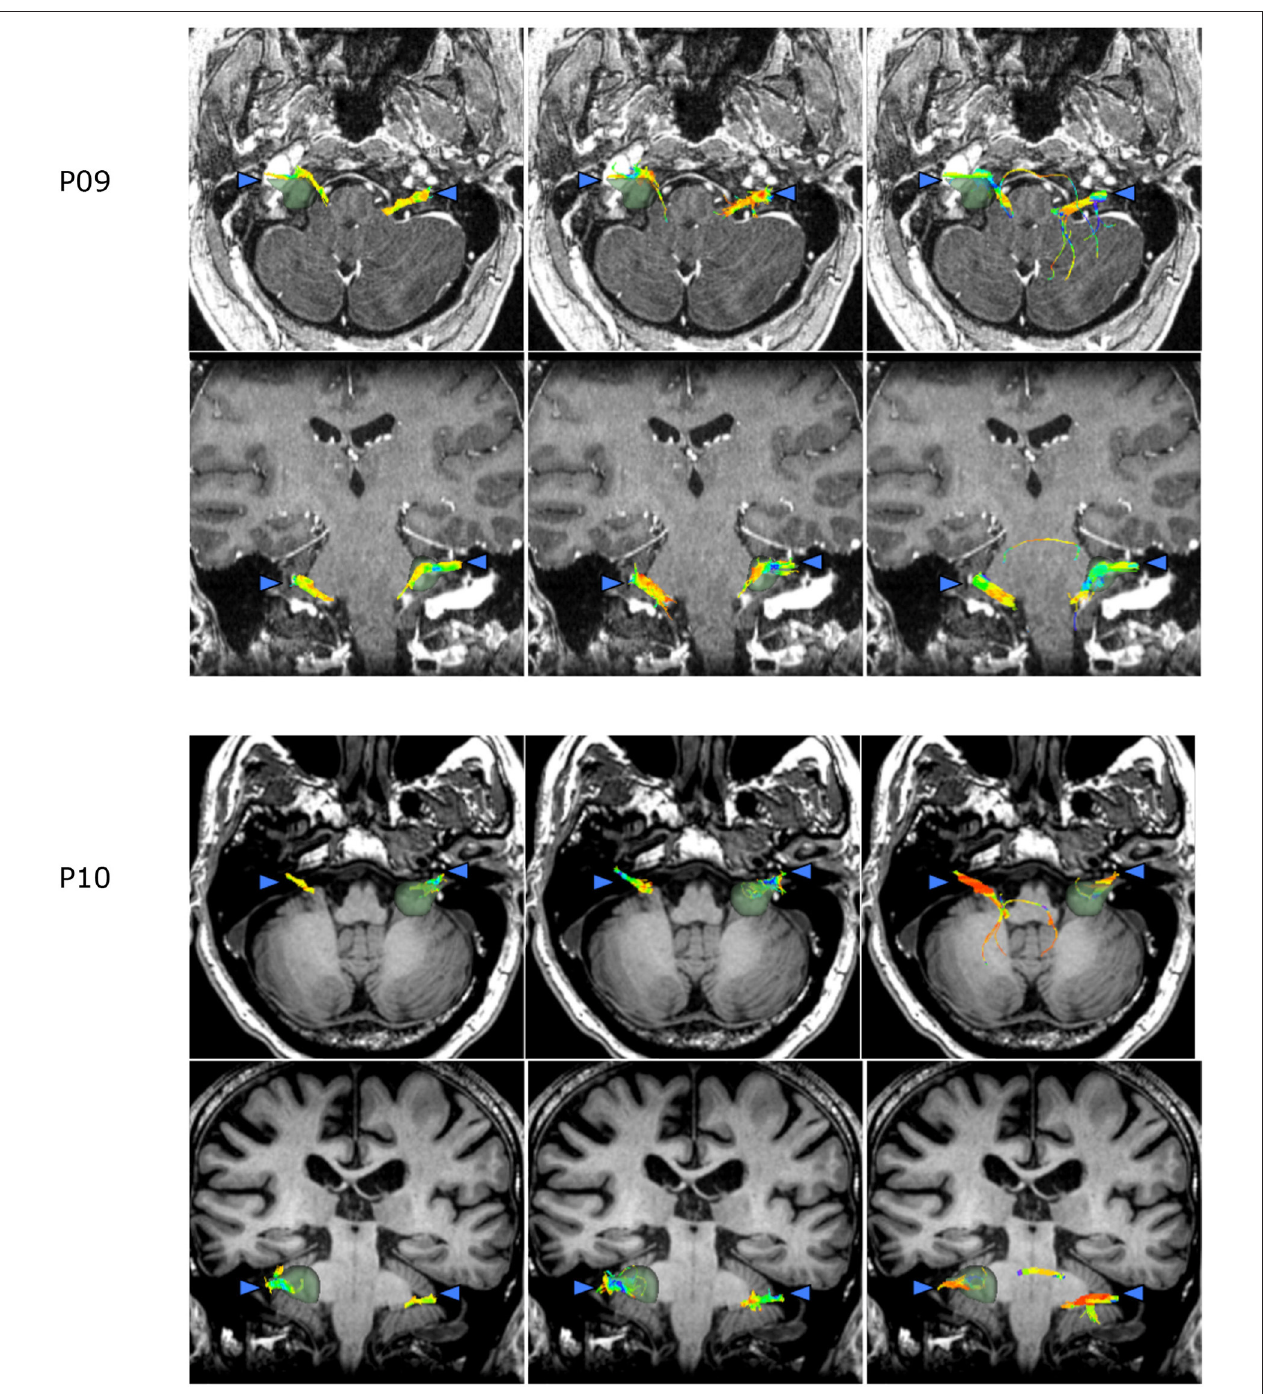
FIGURE 5 | Bilateral CN VII/VIII generated from each of the three reconstruction methods: Single Diffusion Tensor Tractography (SDT), EXtended Streamline tractography (XST), Streamline tractography on fiber orientation distributions (FODs) derived from constrained spherical deconvolution (CSD) is displayed. Streamlines are displayed overlaid on a T1 anatomical image from a superior and anterior view. Colored triangles indicate particular anatomical landmarks: blue indicates cranial nerves, green indicates superior cerebellar fibers, yellow indicates trigeminal brainstem nuclei. SDT was able to display anatomically accurate cisternal portions of CN VII/VIII on sides contralateral to lesions (P06–SDT). However, XST and CSD-based tractography produced longer sections of CN VII/VIII (P10–SDT, XST, CSD). On affected sides, SDT could only generate small cisternal segments (P08–SDT). XST and CSD-based tractography depicted longer cisternal segments (P08–XST, CSD). However, CSD-based tractography also generated several anatomically inaccurate fibers when generating CN VII/VIII in this patient (P08–CSD).